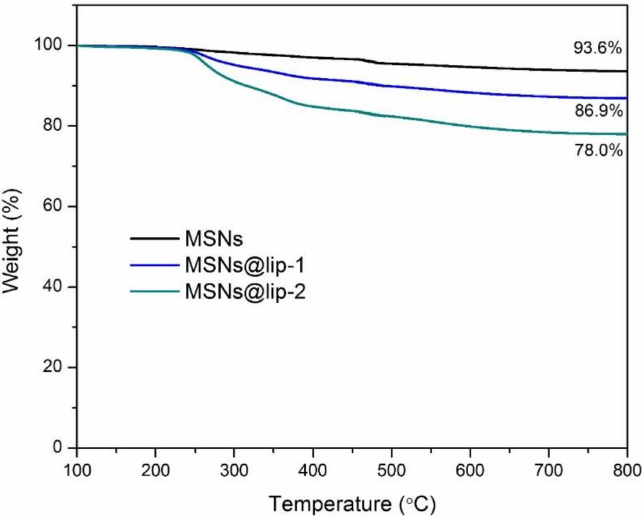
Figure 3. TGA curves of MSNs, MSNs@lip-1 and MSNs@lip-2. The content of phospholipid layer in MSNs@lip-1 and MSNs@lip-2 is calculated to be 7.2% and 16.7%,